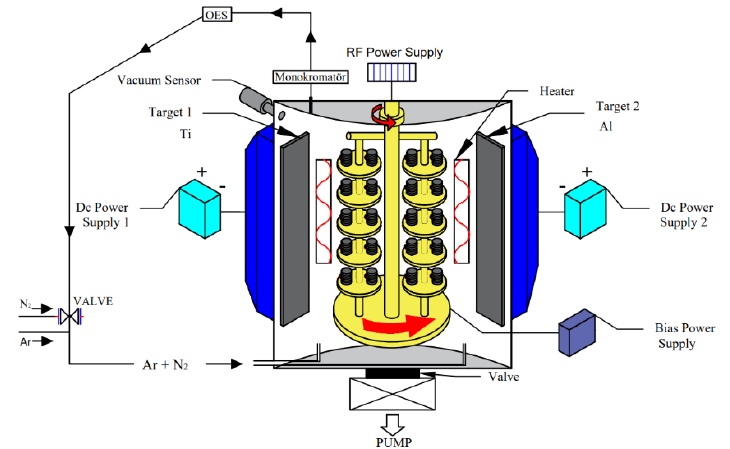
Figure 1. Schematic view of the vacuum chamber and magnetron sputtering coating